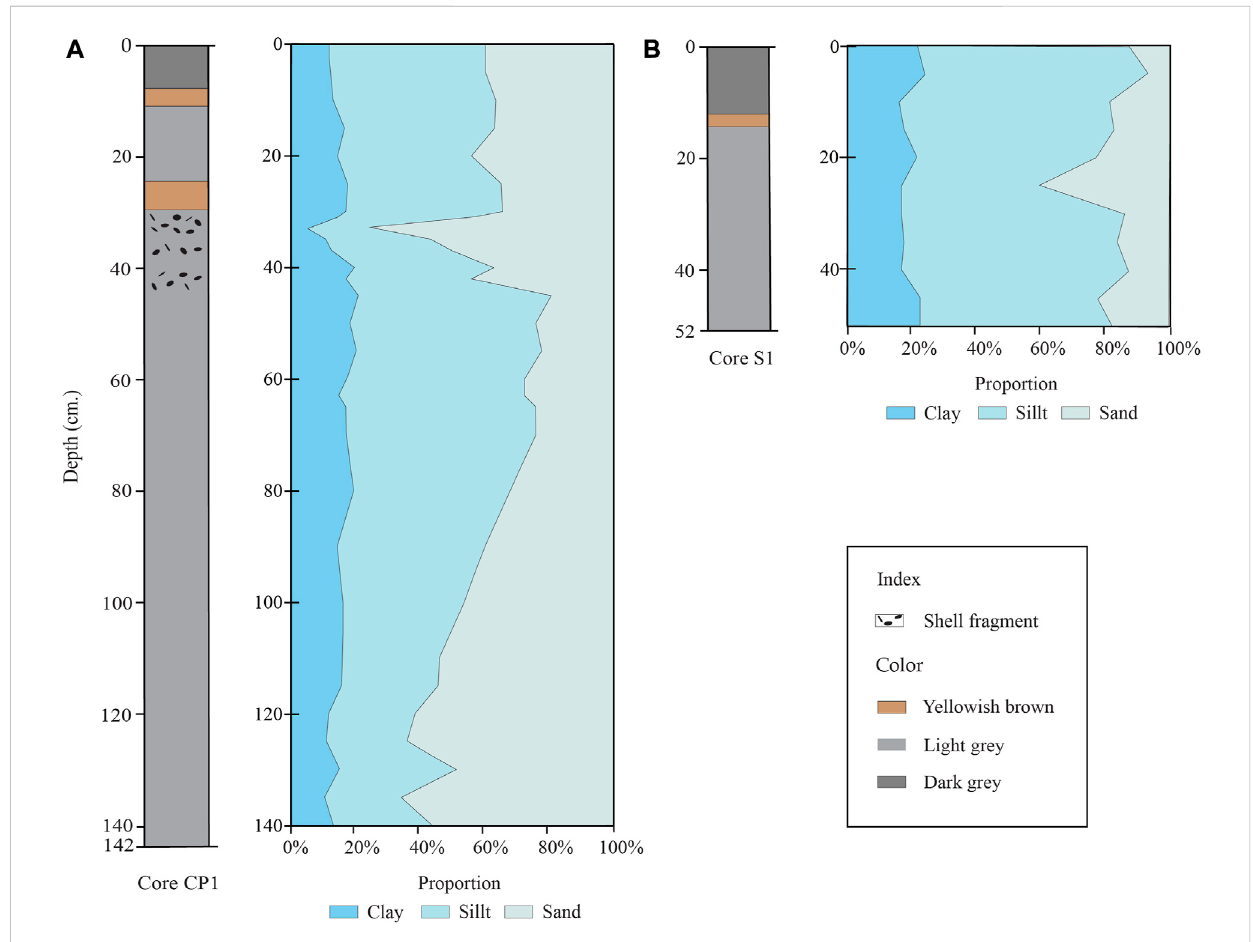
FIGURE 2 Lithostratigraphy and grain size proportion of the (A) CP1 core and (B) S1